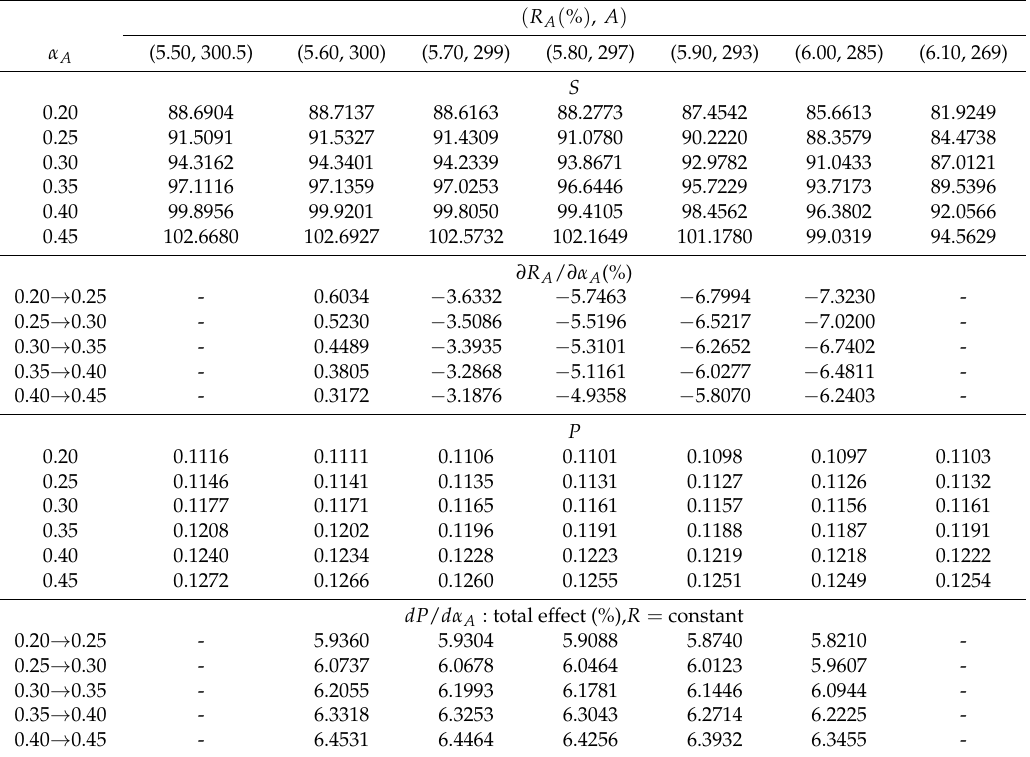
Table 2. Responsiveness of asset-side interest margin (asset interest rate) and default risk to CEO overconfidence degree based on Equations (12) and (14) 1